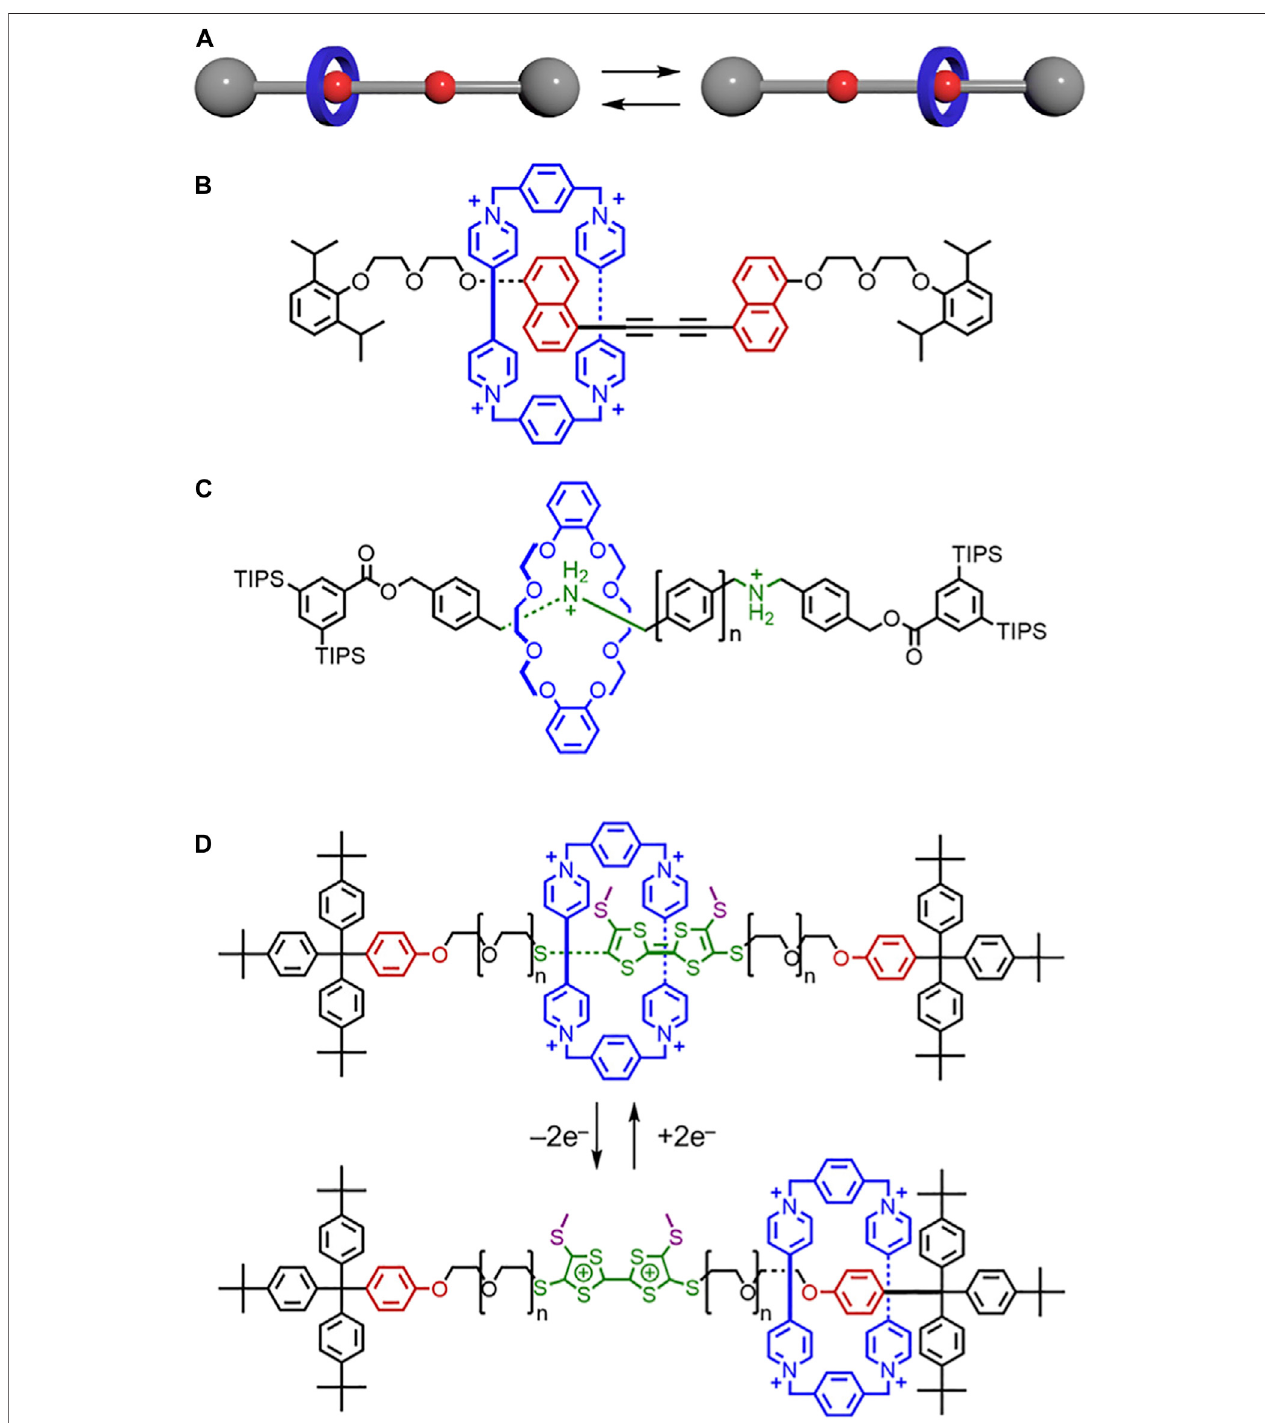
FIGURE 14 | (A) Translational motion between isomers in a molecular shuttle. (B) Shuttle composed of a CBPQT 4+ macrocycle and a rigid thread. (C) Shuttle composed ofacrown ether macrocycleand athread with rigid phenyl linkers. (D) Molecularswitch composed ofaCBPQT 4+ macrocycleand athread with fl exible PEG